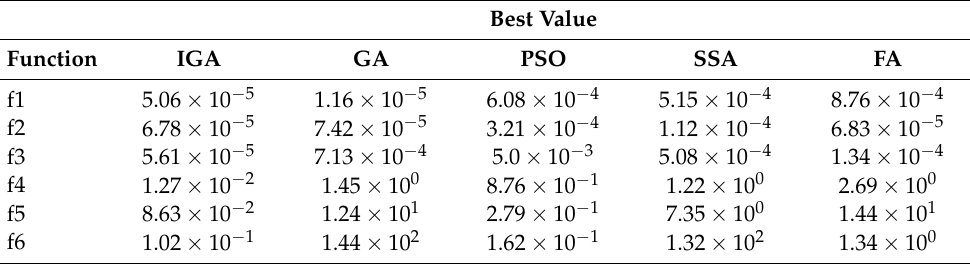
Table 2. Best value different of test functions about six algorithms.